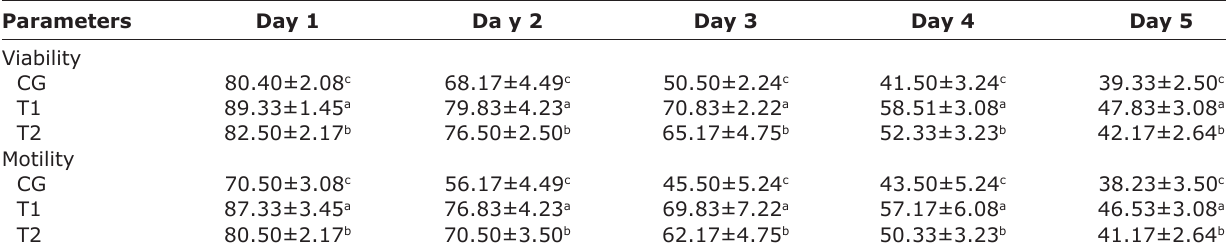
Table-2: Effect of L-arginine addition in skim milk extender and chilled for 5 days evaluation on viability and motility (%) of goat spermatozoa. Parameters